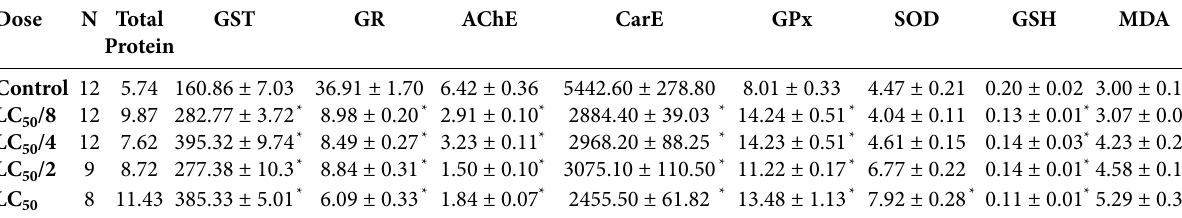
Table 3. Biochemical responses of 96-h Thmx exposure in hepatopancreas. Total protein amount expressed as mg ml –1 , and enzyme activities ex- pressed as nmol min –1 mg protein –1 ± mean standard error. GSH and MDA levels expressed as nmol GSH mg protein –1 ± mean standard error and nmol MDA mg protein –1 ± mean standard error,